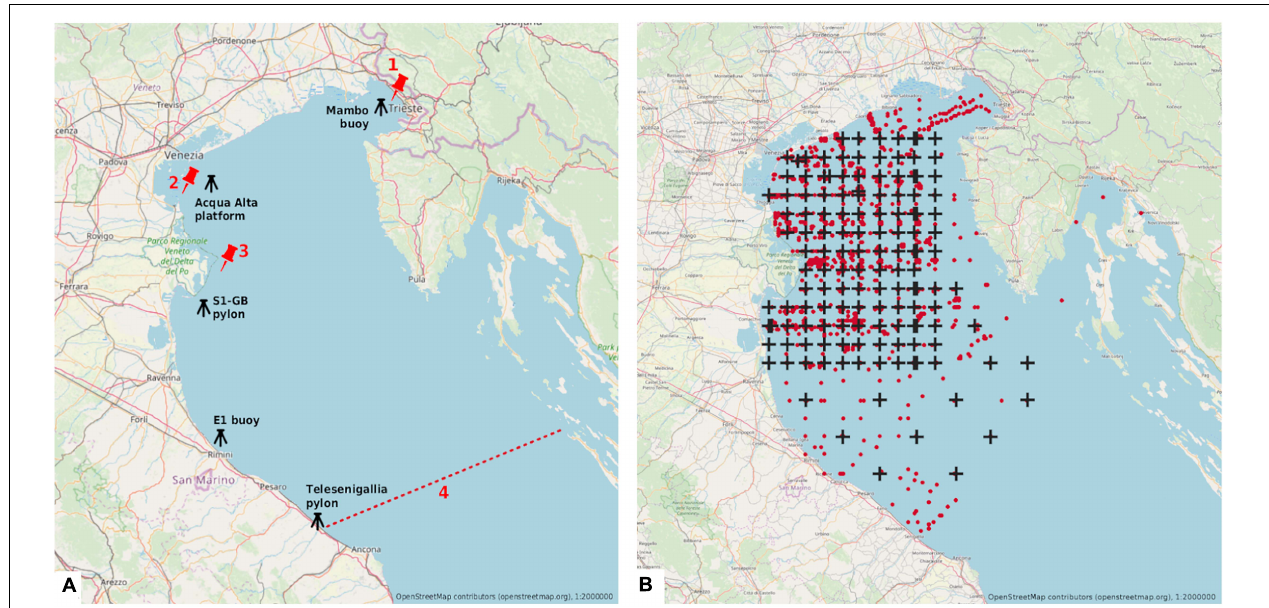
FIGURE 2 | (A) the LTER-Italy parent site Northern Adriatic Sea, with its four LTER sites (red pins) and dots: 1-Gulf of Trieste; 2-Gulf of Venice; 3-Po Delta and Romagna Coast; 4-Senigallia-Susak Transect. The fixed point observatories at each research site are represented by black icons (see Ravaioli et al., 2016 for a full description). (B) spatial distribution of data (red dots) and sampling stations (black crosses), covered during the period 1965–2015. Base map credits: OpenStreetMap contributors 2019. Distributed under a Creative Commons BY-SA